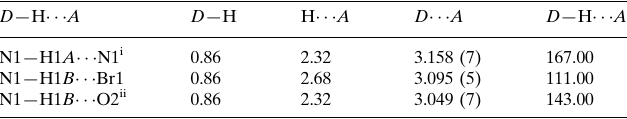
Hydrogen-bond geometry (A˚ , (cid:1)